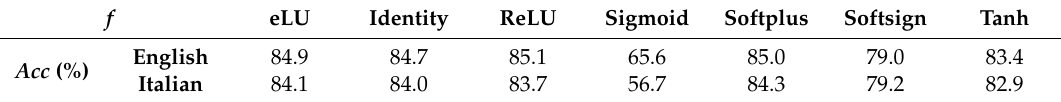
Table 12. Testing accuracy obtained by different activation functions 1 .